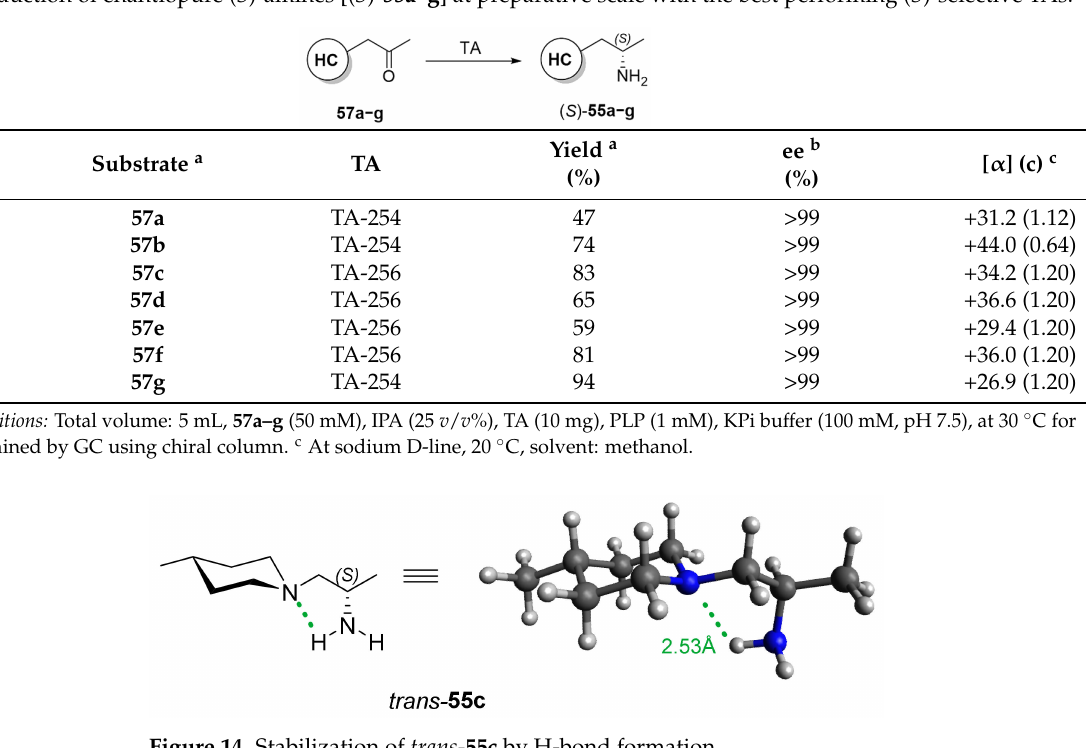
Table 4. Production of enantiopure ( S )-amines [( S )- 55a–g ] at preparative scale with the best performing ( S )-selective TAs.